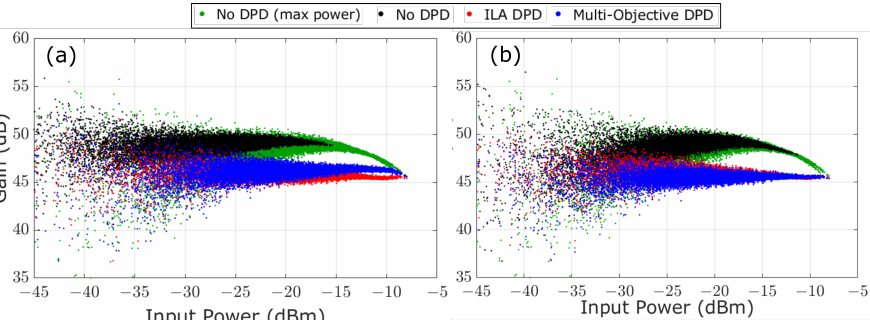
Figure 8. Instantaneous gain characteristics obtained with the proposed multi-objective optimization (blue), compared with the classical ILA approach (red) and the case without DPD (black). ( a ) same level of ACPR (cid:39) − 33 dB, corresponding to the intercepts of the vertical dashed line in Figure 6a; ( b ) same level of ¯ P OUT (cid:39) 0.7 W, corresponding to the intercepts of the horizontal dashed line in Figure 6a. Green lines show the maximum output power performance without DPD at − 4 dB compression ( ¯ P OUT (cid:39) 1.3 W, ACPR (cid:39) − 27